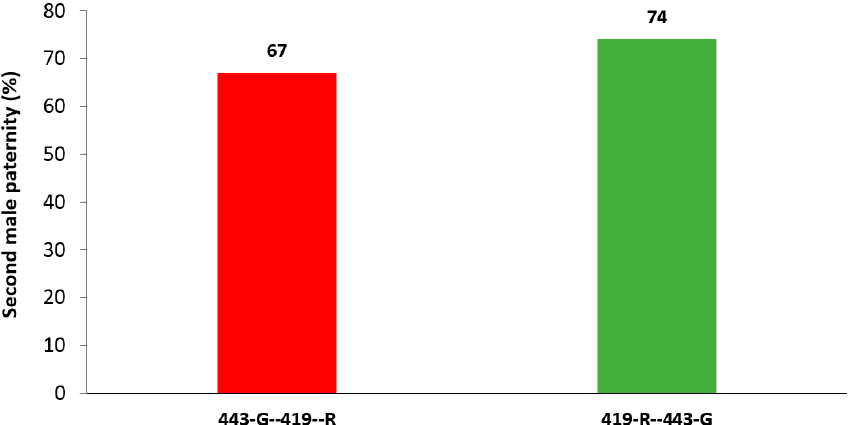
Figure 1. Second male paternity. Percentage of A. ludens red fluorescent offspring produced by a female mating first with a 443-G male and then mating with a 419-R male (red bar), or green fluorescent offspring produced by females mating first with a 419-R male and then a 443-G (green bar) male.